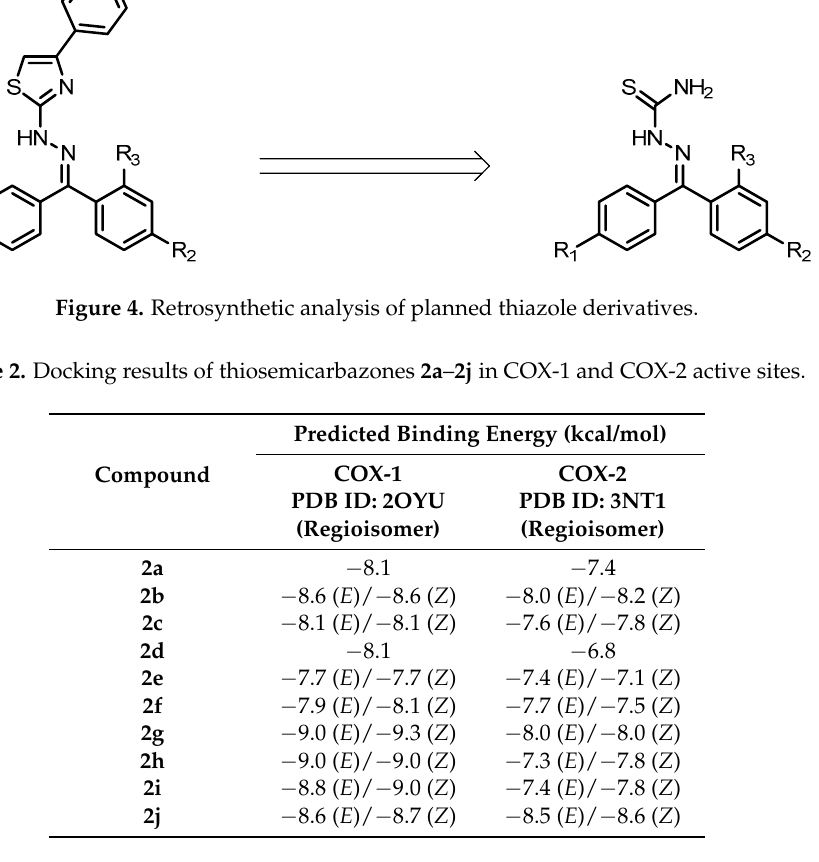
Table 2. Docking results of thiosemicarbazones 2a – 2j in COX-1 and COX-2 active sites.